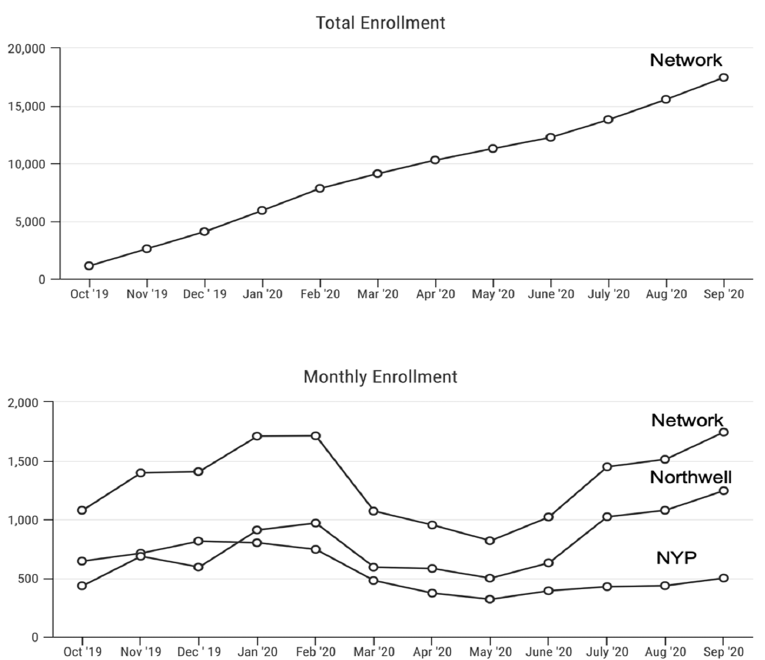
Figure 2. Data dashboard: NBSTRN created a monthly dashboard that included monthly and total enrollment numbers for Northwell, NYP, and overall network.